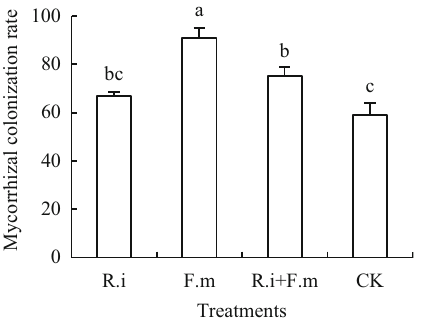
Fig. 2 Effect of AM inoculation on mycorrhizal colonization rate of Amygdalus pedunculata Pall.